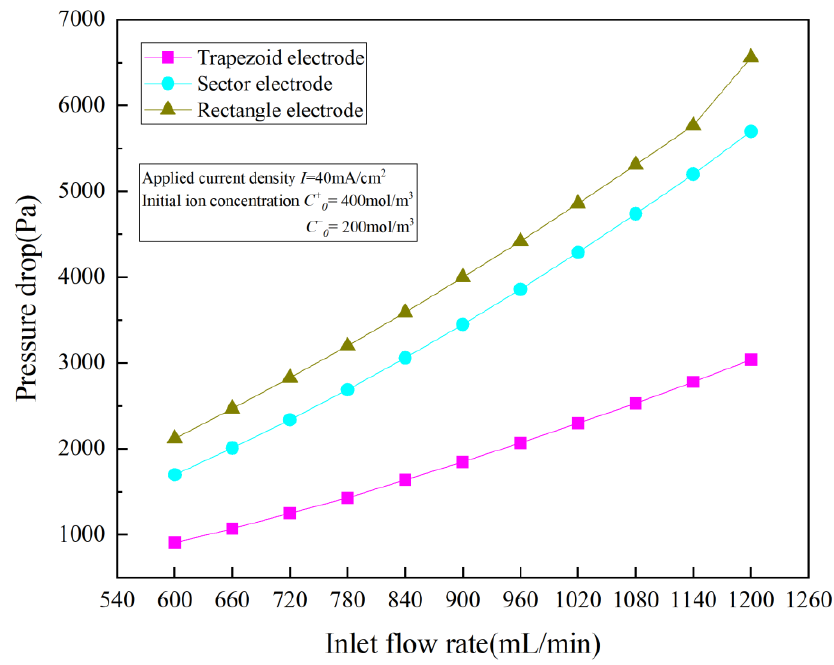
Figure 12. Variations in pressure drops with inlet flow rates under different electrodes.